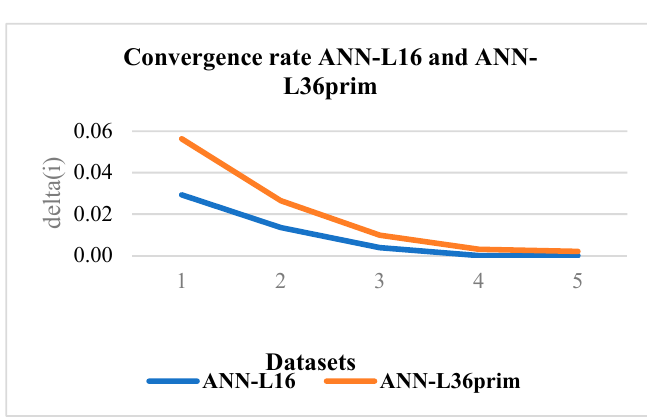
Figure 4. Convergence rate of ANN-L16 vs. ANN-L36prim (UCP). Table 5. ANN-L16 training results.